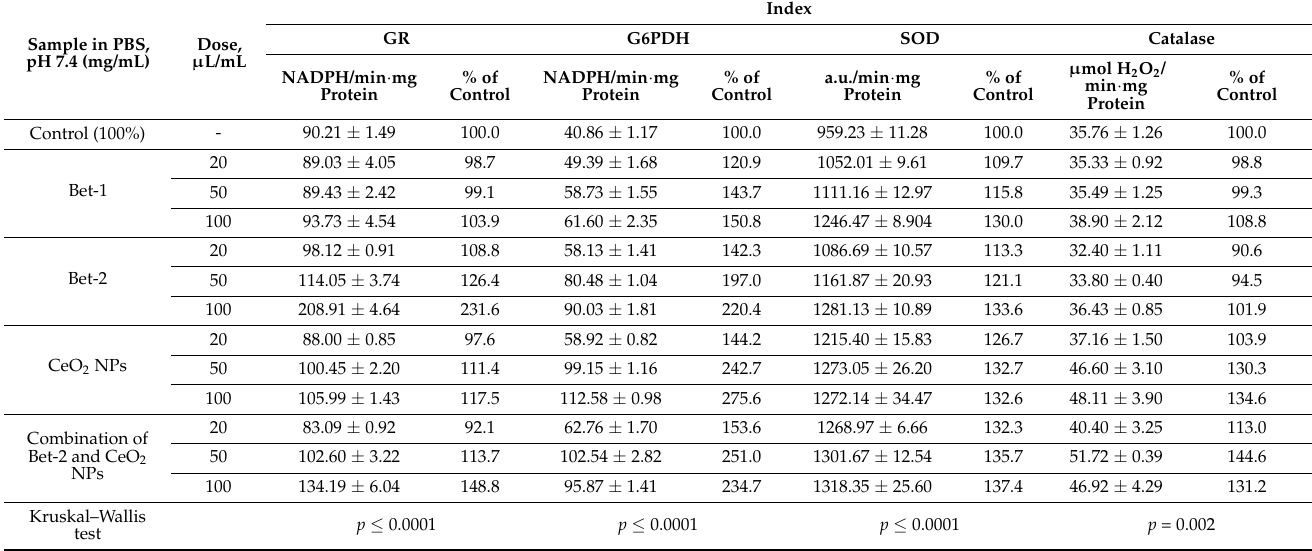
Table 3. The activity of antioxidant defense enzymes in the blood of rats under the action of the studied compounds at the doses of 20, 50, and 100 µ L of the sample per 1 mL of blood as a percentage relative to the control (n =